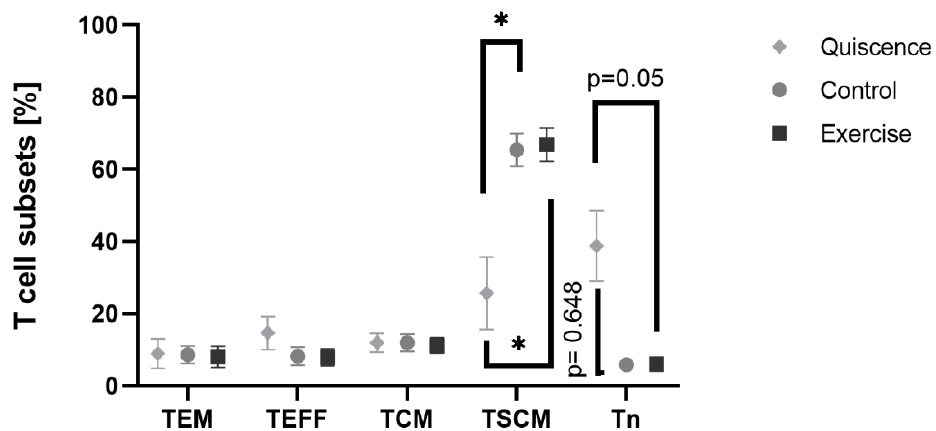
Figure 7. Percentage change in T effector memory cells, T effector cells, T central memory cells, stem cell-like memory T cells, and naive T cells with SEM before activation, at quiescence, and after activation at control and exercise condition. Human CD4+ T cells from cohort 2 were activated in serum before exercise (CO) or after exercise (EX) with anti-CD3/anti-CD28. Quiescent cells remained non-activated. Data are shown with mean ± SEM (Control N = 6, Exercise N = 6, Quiescence N = 4). Significance was determined by Mixed-effect analysis and Tukey’s multiple comparisons. * p < 0.05. TEM: T effector memory cells, TEFF: T effector cells, TCM: T central memory cells, TSCM: stem cell-like memory T cells (TSCM), Tn: naive T